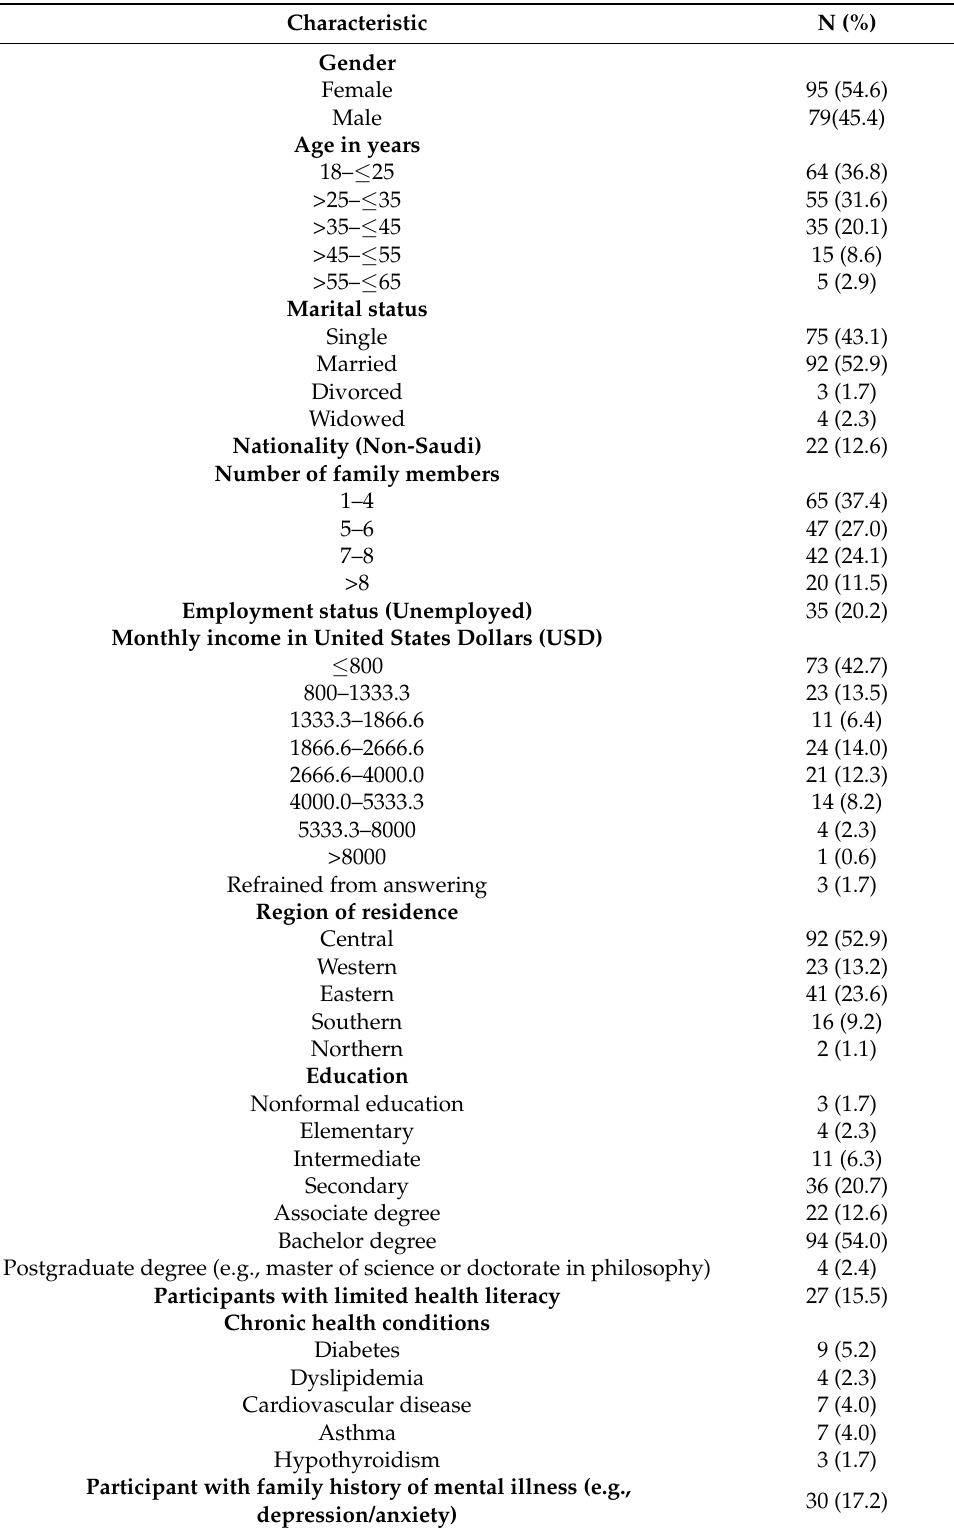
Table 1. Participants’ baseline characteristics (N =